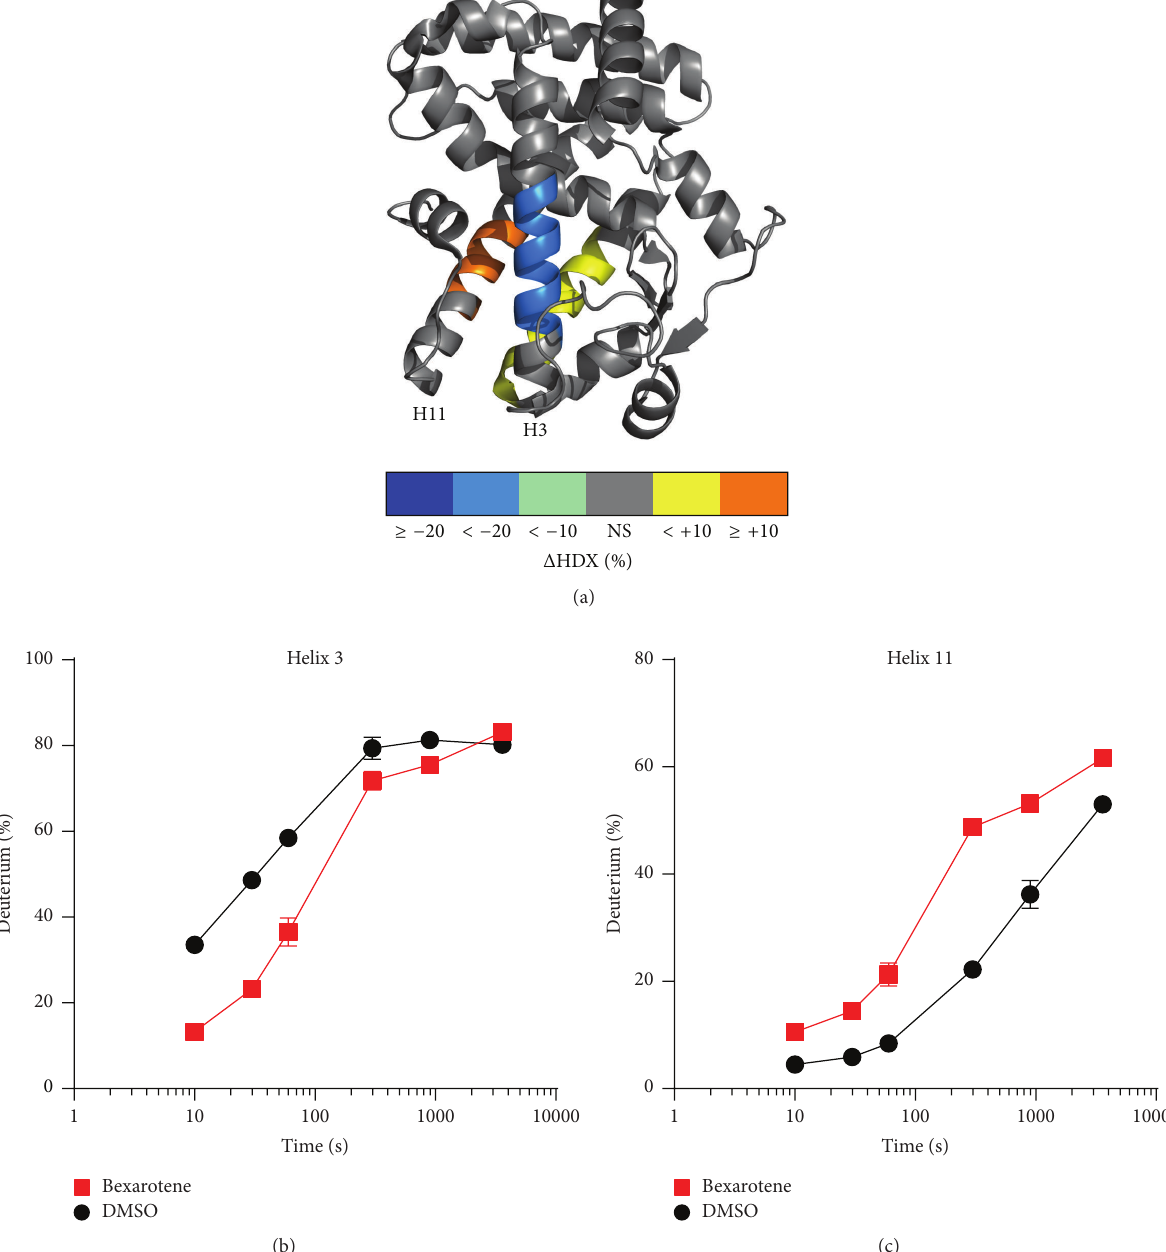
Figure 2: Differential HDX of PPAR 𝛾 with Bexarotene: (a) residues colored corresponding to the average percent change in deuteration between apo and Bexarotene bound PPAR 𝛾 over 6 time points (10, 30, 60, 300, 900, and 3600 seconds) run in triplicate ( 𝑛 = 3 ) overlaid on PDB:1K74. HDX buildup curves of (b) PPAR 𝛾 LBD helix 3 peptide IRIFQGCQ (blue) and (c) PPAR 𝛾 LBD helix 11 RXIVTEHVQL